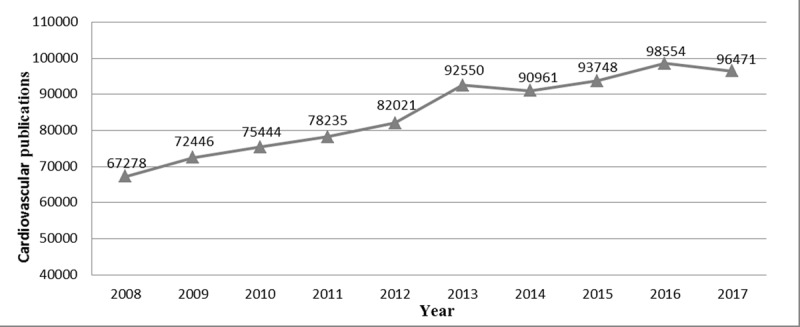
Absolute counts of cardiovascular publications (2008–2017).